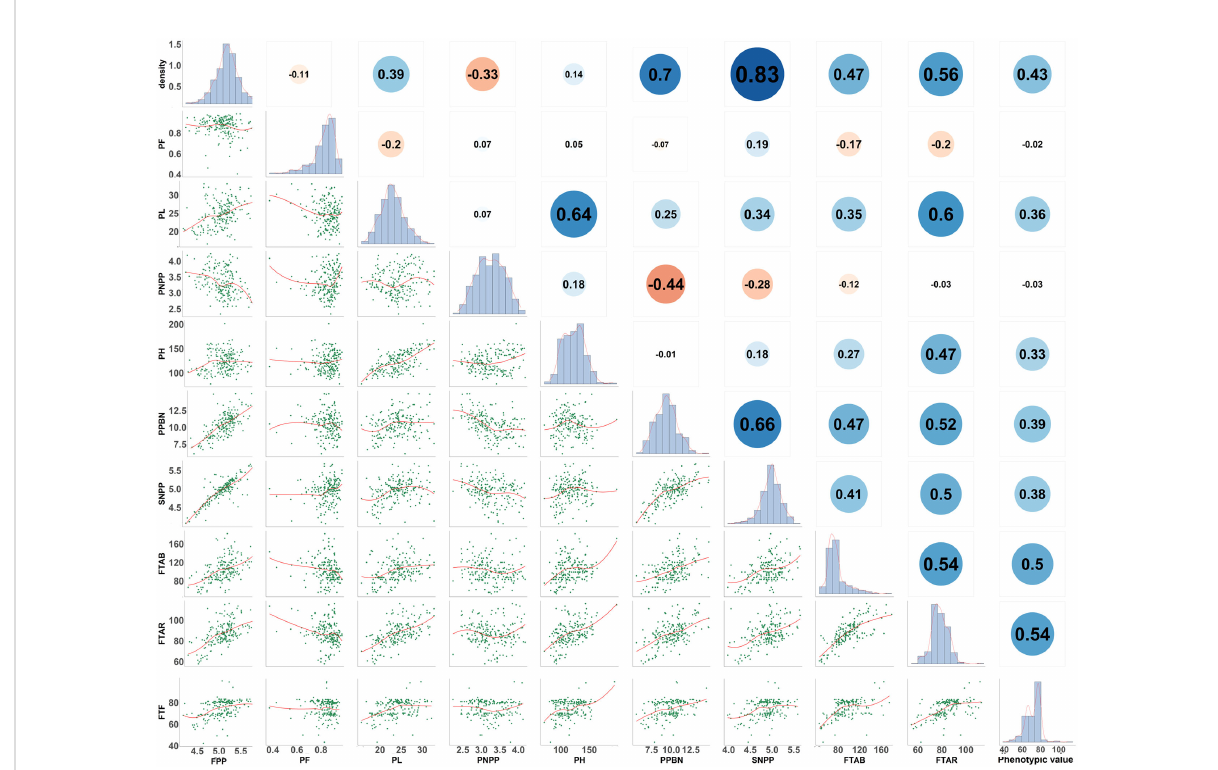
FIGURE 1 Distribution of eight yield-related traits in rice and Pearson coef fi cients. FTAB, FTAR, and FTF are the fl owering time in three different environments in the single-environment analysis. Linear regression statistics between the two traits are below the diagonal, the diagonal histogram represents the distribution of each trait, and correlation coef fi cients are above the diagonal (positive numbers represent positive correlations, negative numbers represent negative